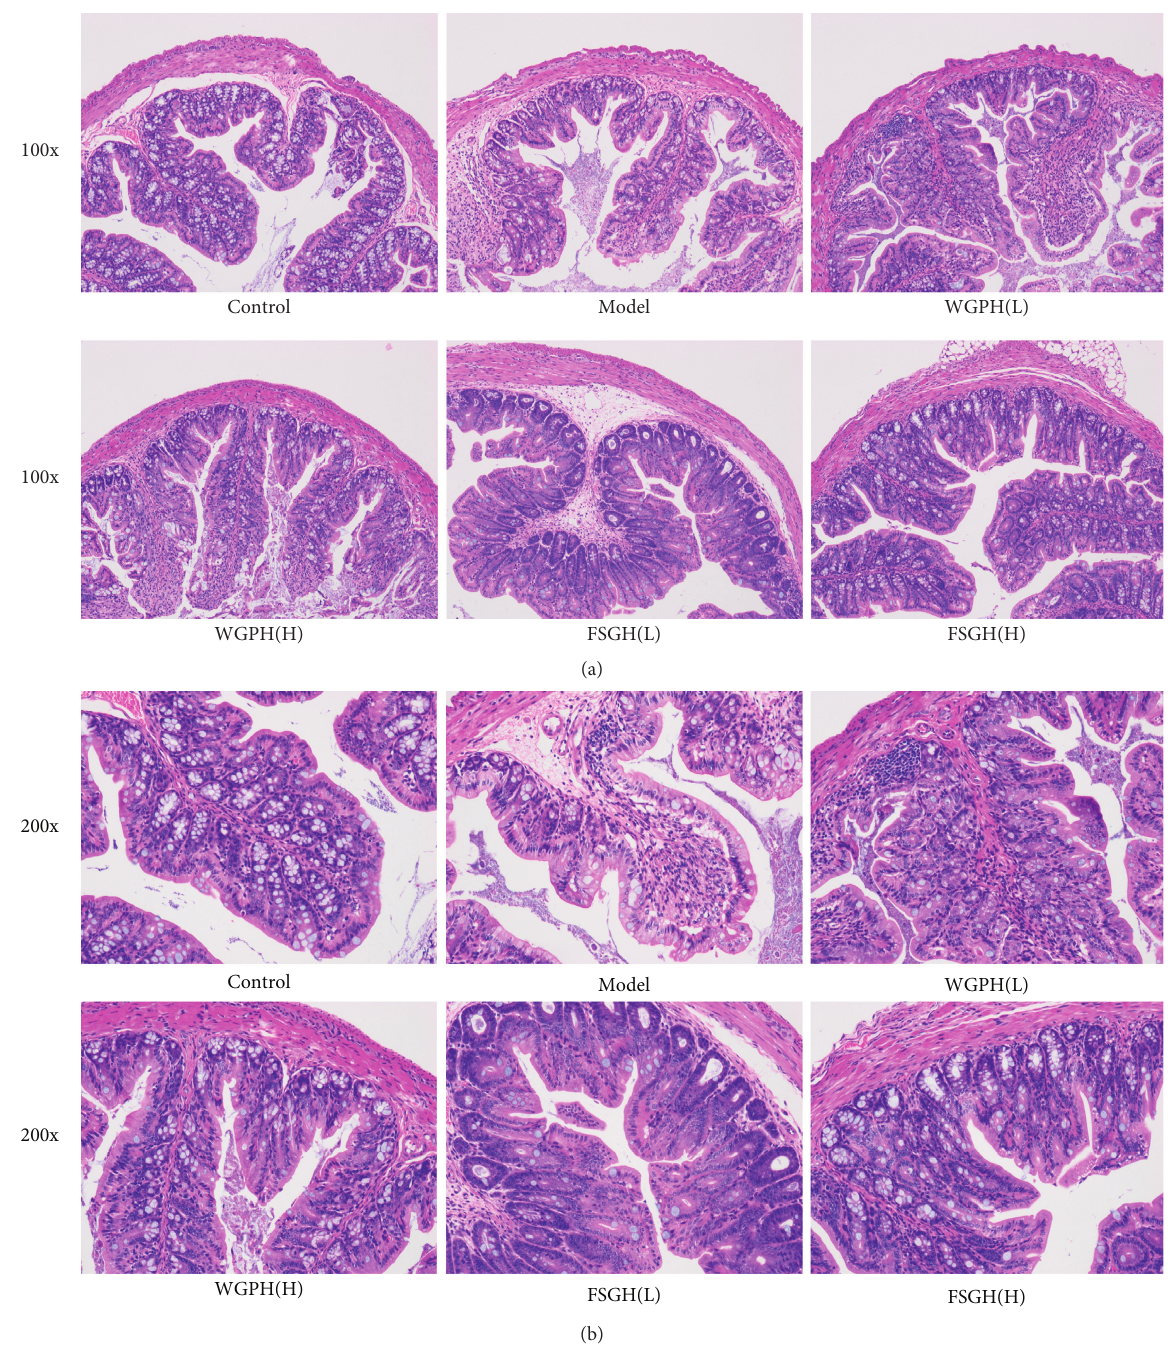
Figure 2: Histological observation and evaluation. (a) Representative photos of colonic segments ( × 100). (b) Representative photos of colonic segments